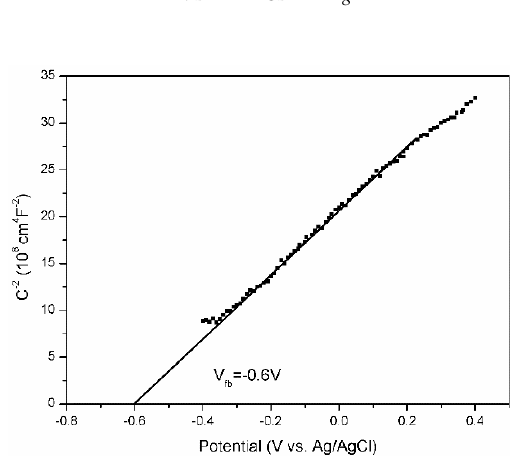
Figure 8. Mott ‐ Schottky plot of AFO ‐ 6 film measured in 0.1 M Na 2 SO 4 . Figure 8. Mott-Schottky plot of AFO-6 film measured in 0.1 M Na 2 SO 4